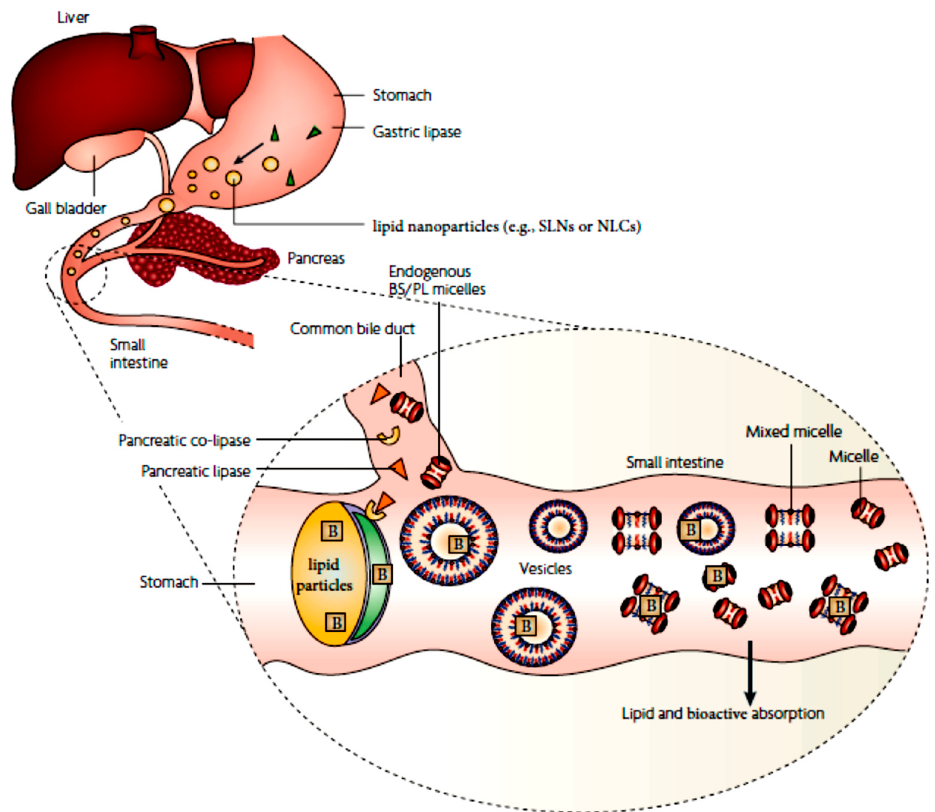
Figure 5. Schematic illustration for lipid digestion of lipid nanoparticles (SLNs and NLCs) and bioactives (B) solubilization in the small intestine. (Adapted from [25]).